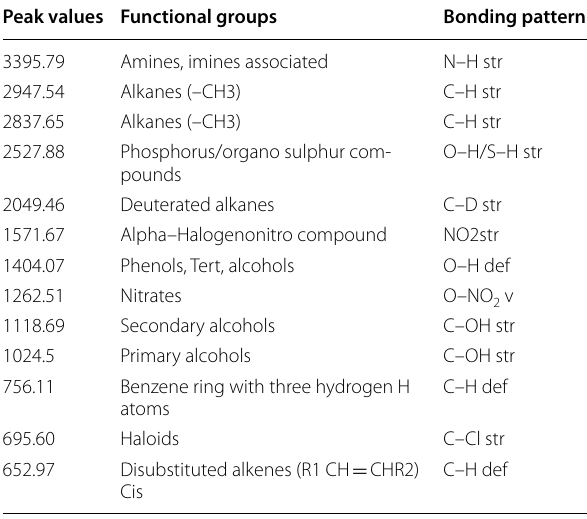
Table 2 FT-IR spectrum of Ocimum gratissimucm leaf extract. Table 3 FT-IR spectrum of Moringa oleifera leaf extract. Source :